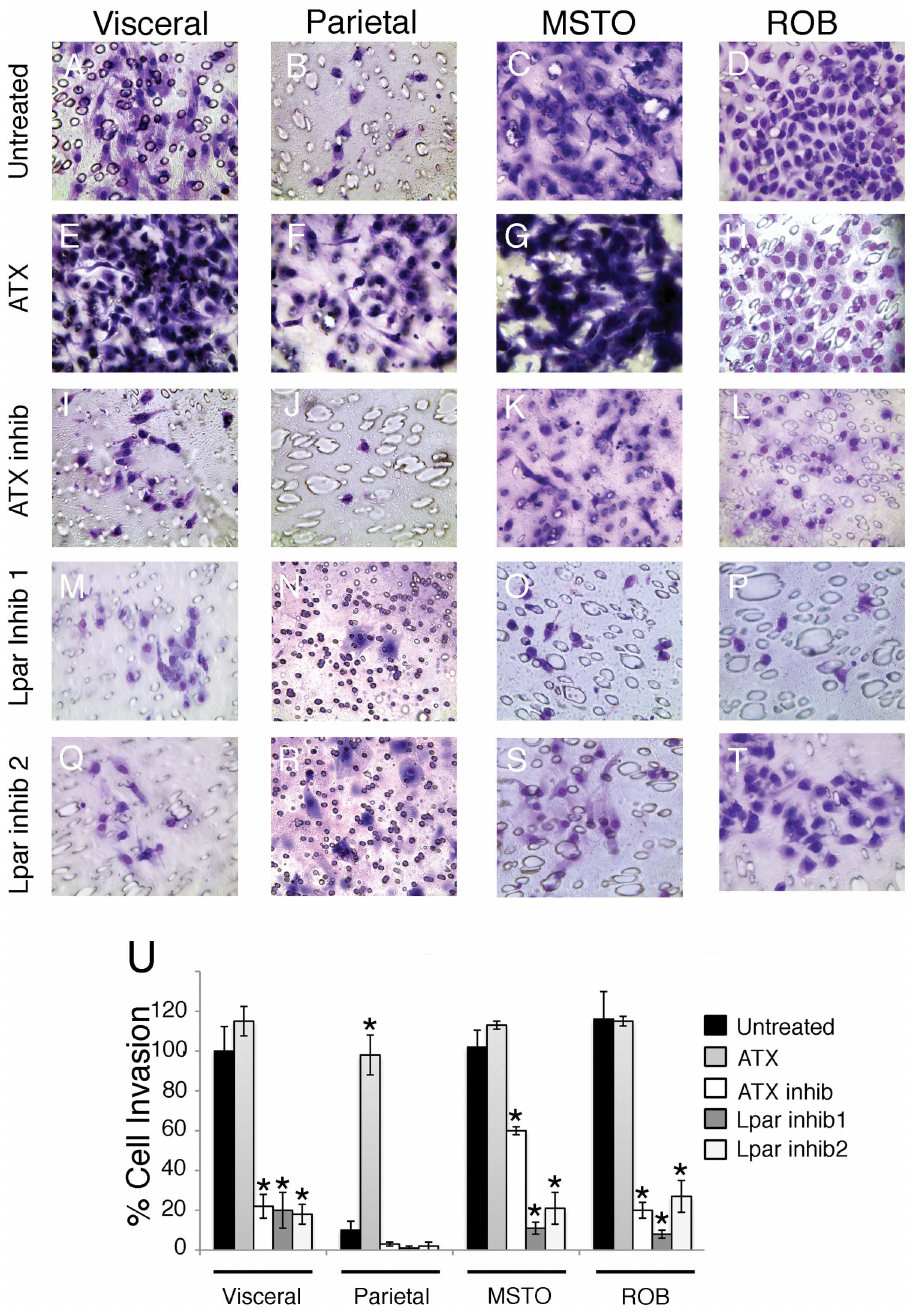
Figure 6. Autotaxin signaling regulates mesothelial and mesothelioma cell invasion. Visceral mesothelial, parietal mesothelial, pleural mesothelioma (MSTO), and peritoneal mesothelioma (ROB) cells were cultured on transwell filters with and without addition of autotaxin (ATX), the autotaxin inhibitor S32826, Lpar1 inhibitor 1 (2440), or Lpar1 inhibitor 2 (8437). Of all the cells studied, the mesothelioma cells were the most invasive (C, D). Visceral cells (A) invaded more readily than parietal (B), but addition of ATX to parietal cells (F) promoted invasion to visceral-like levels. Treatment with S32826 reduced cell invasion in all groups (I-L). Furthermore, both of the Lpar1 inhibitors were efficient at decreasing cell invasion in mesothelial (M, Q) and mesothelioma cells (O, P, S, T). The percent of cell invasion is quantified in panel U. The percent of untreated visceral cells that migrated was set to 100. Asterisks represent statistically significant differences compared to untreated values in each group (p , 0.05, n=4). Error bars were calculated using standard error of the mean. generated for the position of each cell at 20 minute intervals. Cell migration tracks were quantified using the manual tracking plug-in For each cell type, DIC images were recorded every minute for of ImageJ. The position of each nucleus in DIC recordings was 2 h using a DeltaVision imaging system and softWoRx image used as reference points. Displacement values were quantified as acquisition software (Applied Precision). False colored images were